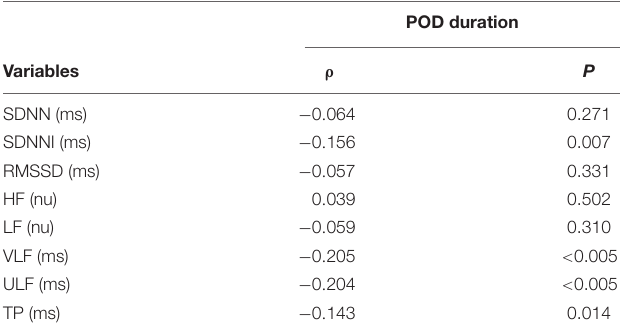
TABLE 4 | Adjusted regression coefficients (95% confidence interval) between HRV parameters and POD.